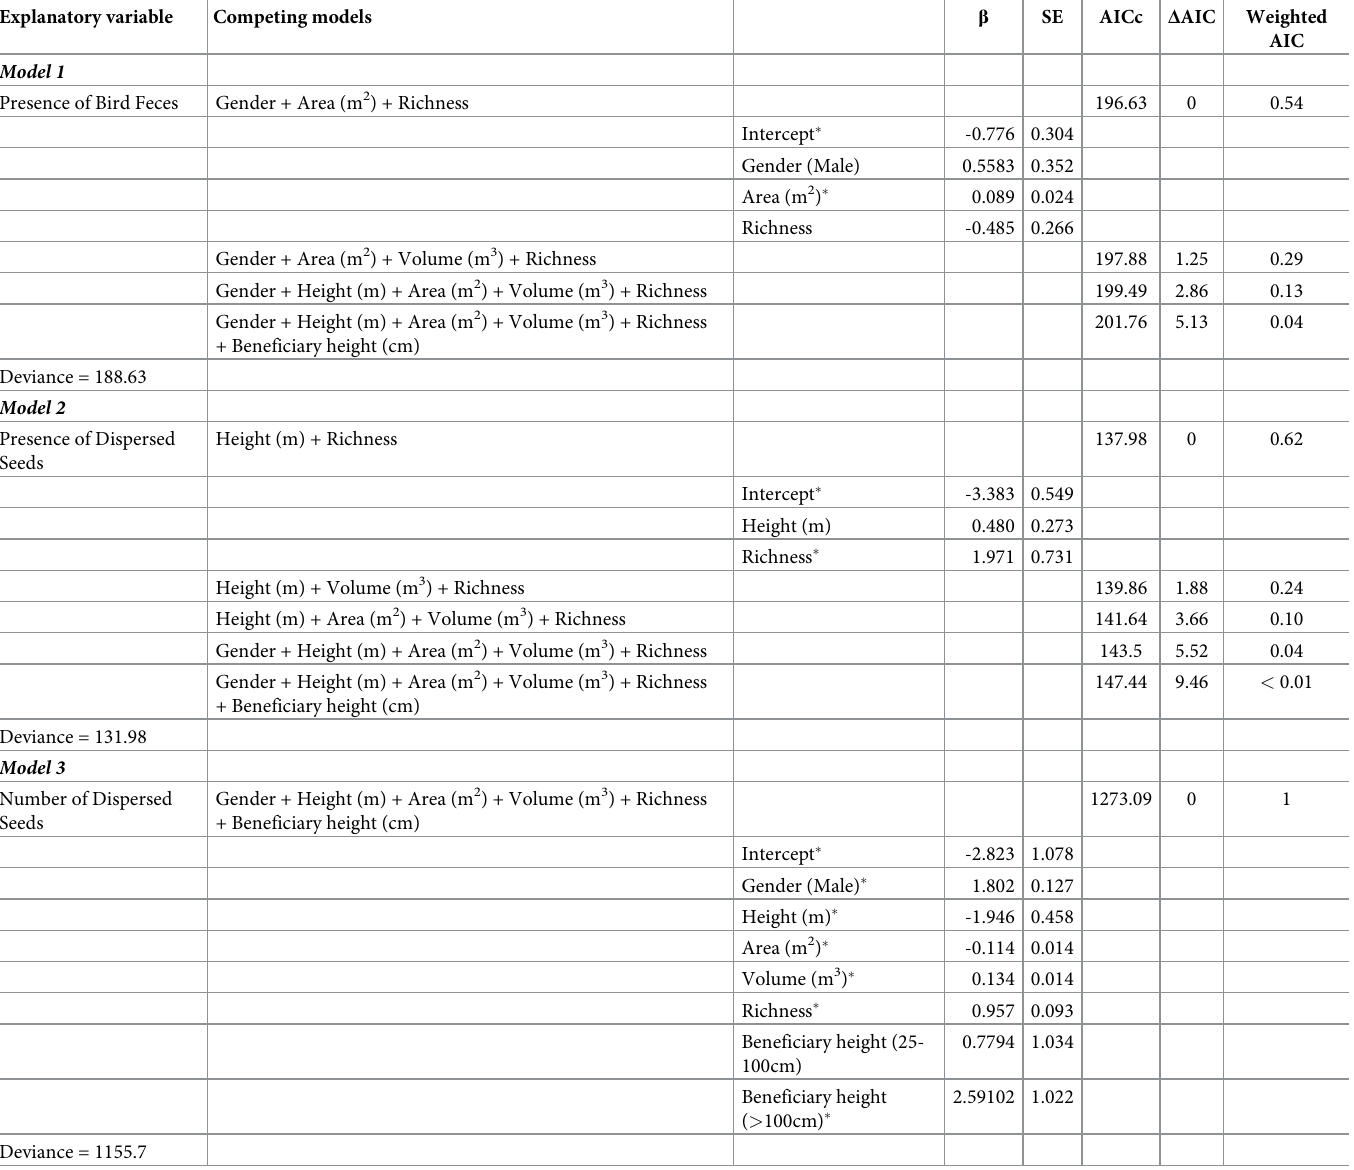
Table 3. GLM carried out to analyze the palm traits the late-successional plot. Explanatory